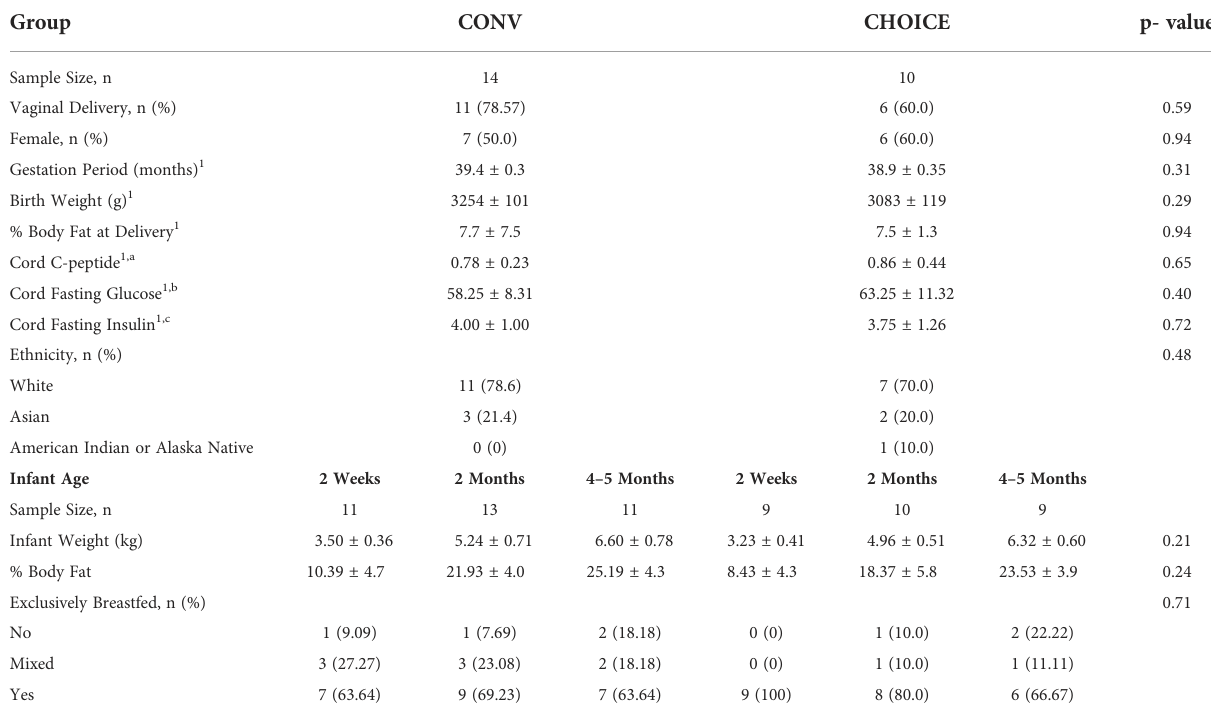
TABLE 2 Infant population characteristics. Group CONV CHOICE p-